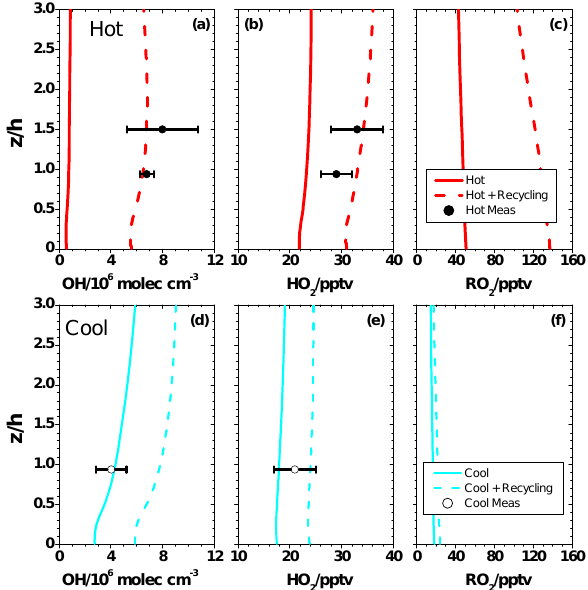
Fig. 4. Profiles of modeled OH, HO 2 and RO 2 mixing ratios during the hot (a–c) and cool (d–f) periods. Solid lines are re- sults from model runs without the enhanced OH recycling mech- anism (Sect. 3.2), while dashed lines represent model runs with OH recycling on. Filled and open circles represent observations (mean ± 1 σ ) for the hot and cool periods,